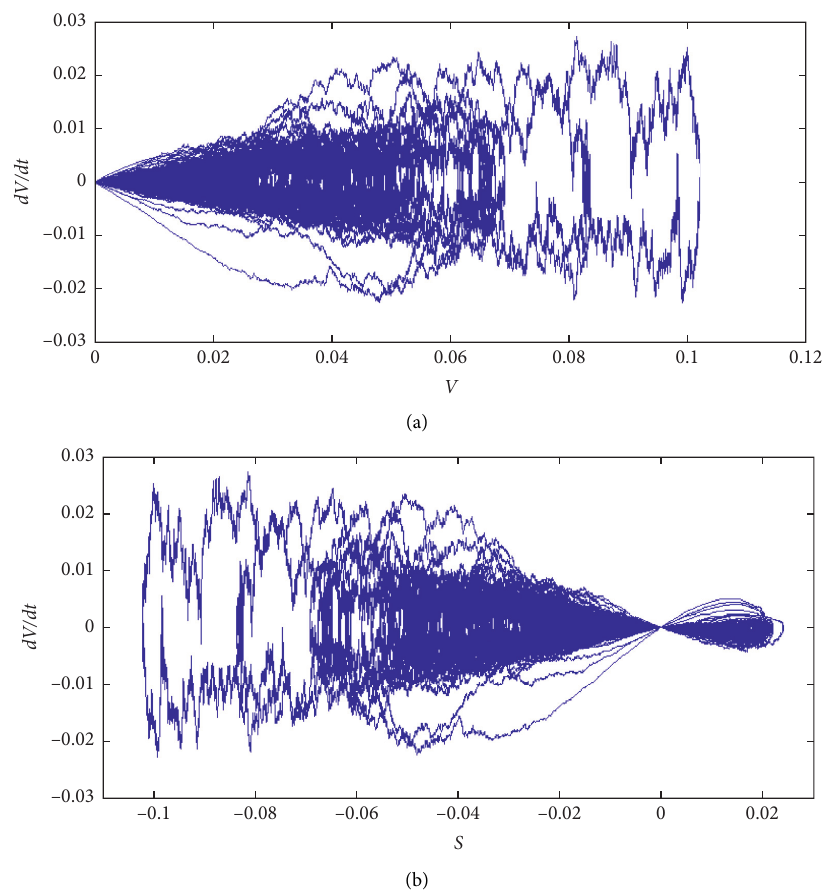
Figure 19: d V /d t versus V and s for the controlled system with σ � 0 . 5. (a) d V /d t versus V and (b) d V /d t versus s